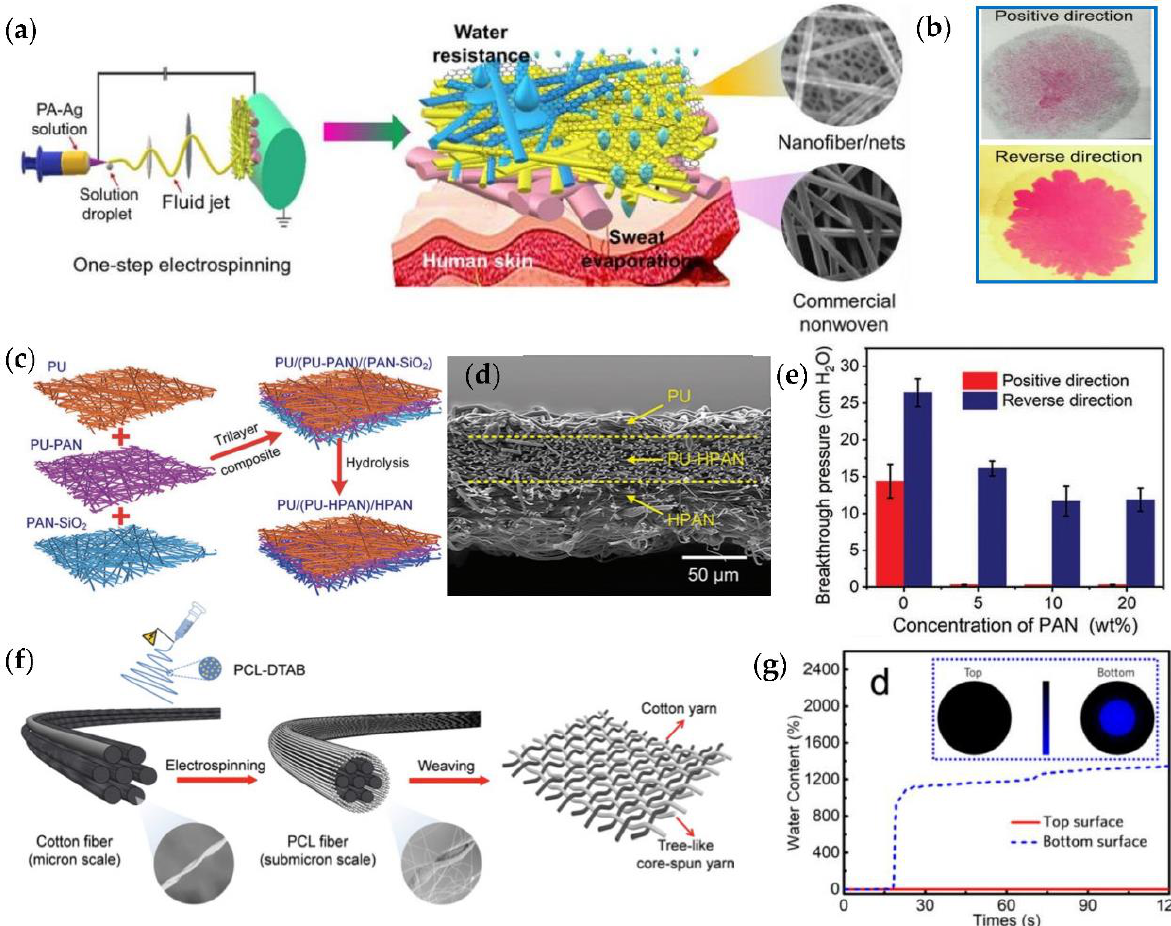
Figure 7. ( a ) Schematic illustration of the fabrication process of the composite CNW/PA-Ag nanofiber-net membrane. ( b ) Water drops onto the hydrophobic CNW side and penetrates the membrane. ( c ) Structure of trilayered PU/(PU-HPAN)/HPAN fibrous membrane [58] (Copyright 2021, Elsevier Inc.). ( d ) Cross-sectional SEM image of trilayered fibrous membrane. ( e ) Anisotropic breakthrough pressure of the trilayered fibrous membranes [59] (Copyright 2018, Wiley-VCH). ( f ) Pro- cess of electrospinning to prepare tree-like core-spun yarns and fabrics. ( g ) MMT results for tree-like core-spun yarn-based fabrics [60] (Copyright 2019, American Chemical